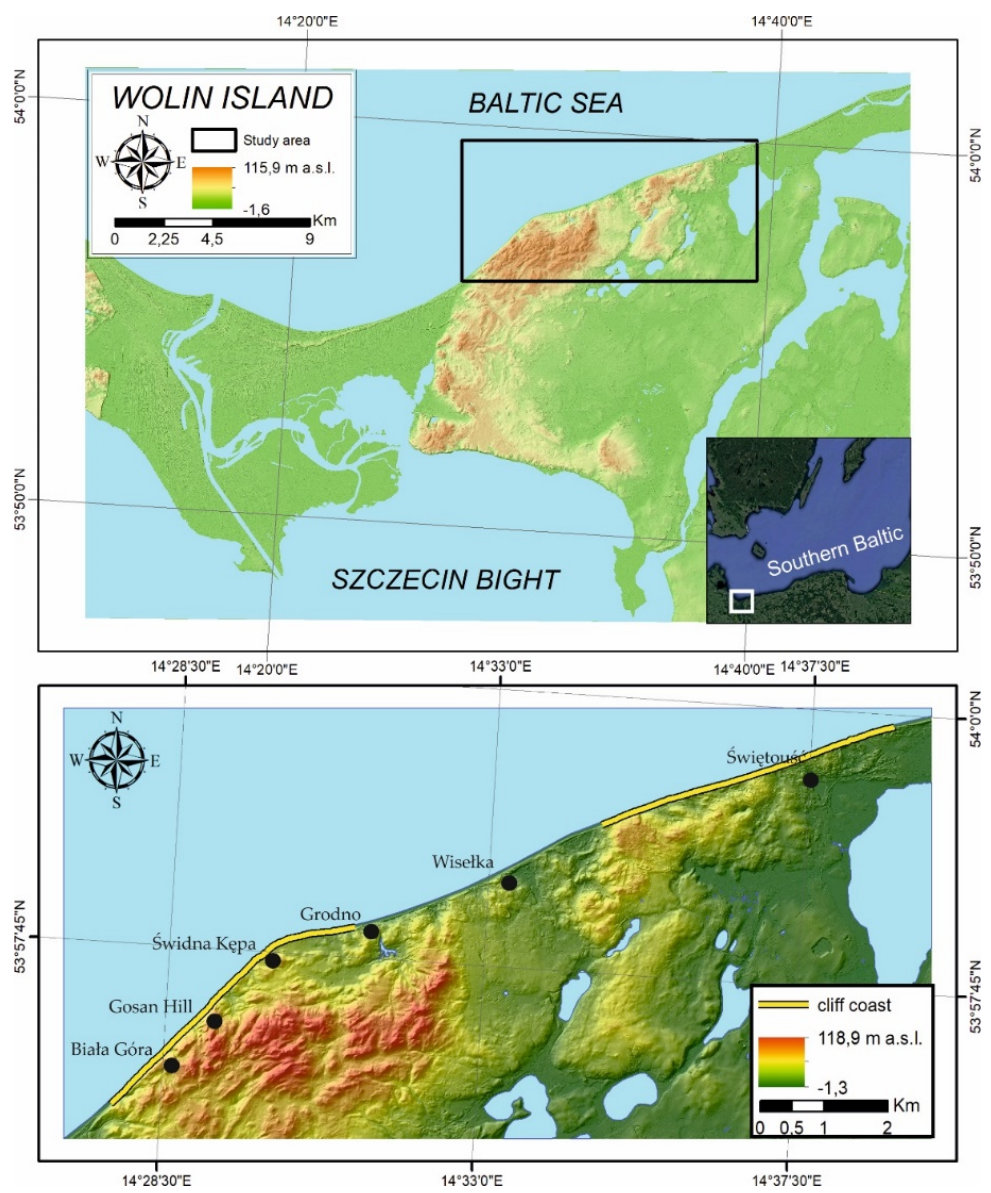
Figure 1. Study area. The map shows the western and eastern section that have been subjected to erosion analyses (Source: this study).